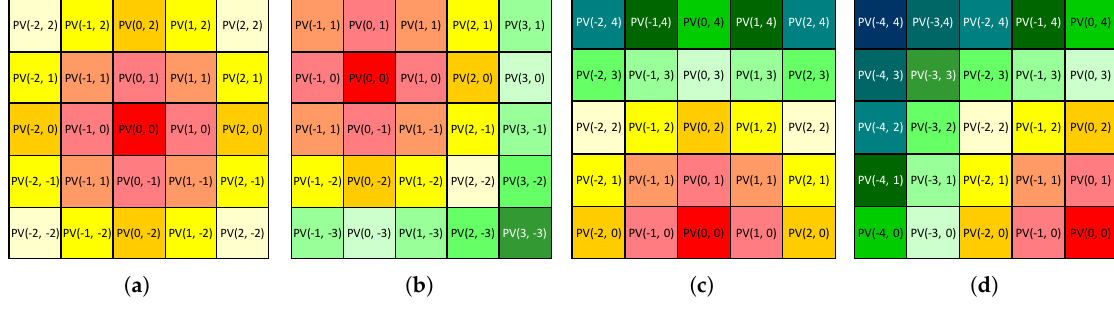
Figure 1. Cell arrangement in a 5 × 5 PV array: highest irradiance cell is located at ( a ) center position (3, 3), ( b ) upper left side (2, 2), ( c ) bottom center side (5, 3), and ( d ) bottom right side (5, 5).